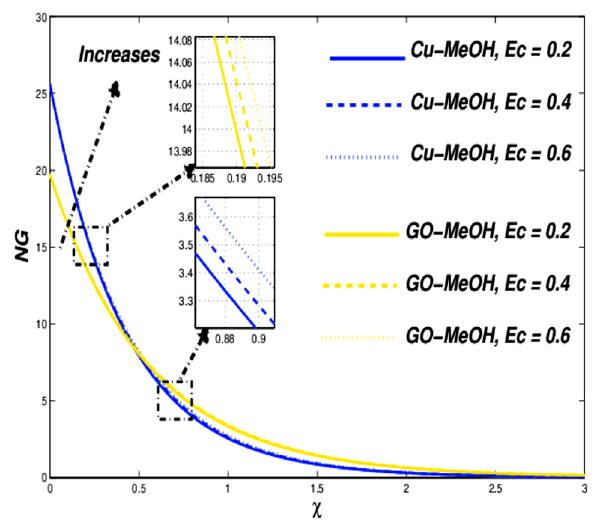
Figure 19. Entropy variation versus Ec